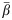
Robustness of expression profiles from the CLASH interactome in the presence of crosstalk.(a) Coefficient of Variation (CV) of RNA levels as a function of the overall mean miRNA transcription rate β¯ for different degrees of TH. (b) Behaviour of the CV as a function of β¯ in different BH scenarios in a fixed TH scenario (CVtr = 0.4). (c) Comparison between the rescaled normalized maximal susceptibility χ˜max (varying between 0 and 1) and the rescaled normalized Coefficient of Variation CV˜ as a function of the overall mean miRNA transcription rate β¯ at fixed TH (CVtr = 0.4) and BH (high). (d)
χ˜max vs CV˜ for different degrees of transcriptional heterogeneity (CVtr) and high BH. Results are obtained by averaging over 1000 independent TH realizations. In each case the standard error of the mean is equal to or smaller than the size of the markers.